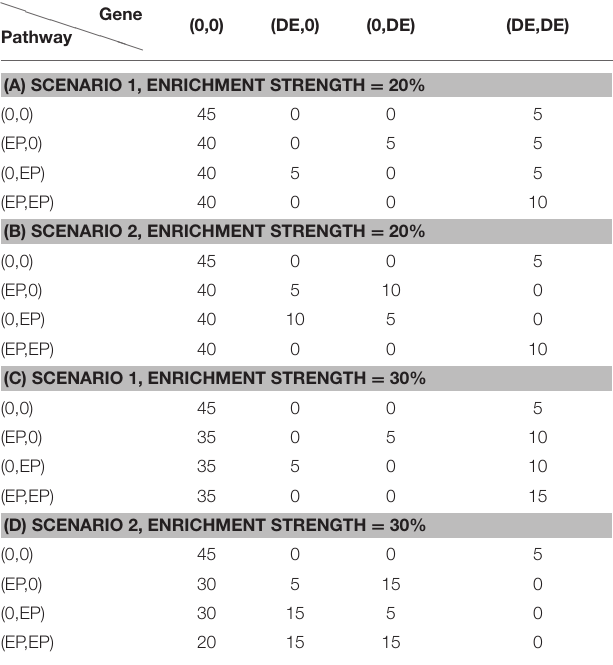
TABLE 1 | Simulation parameter setup under different